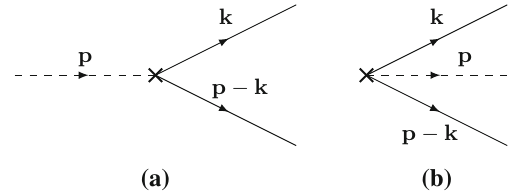
Fig. 1 Production of massless fermions a with and b without proper decaying massive state. The dashed line corresponds to the massive scalarandthesolidlinestomasslessfermions.Thevertexcrossindicates gravitational influence